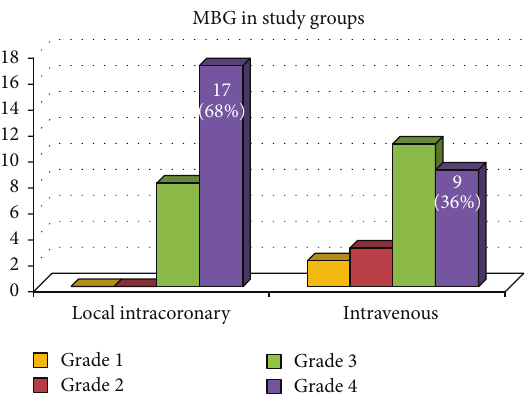
Figure 1: Comparison between 3 groups in MBG.